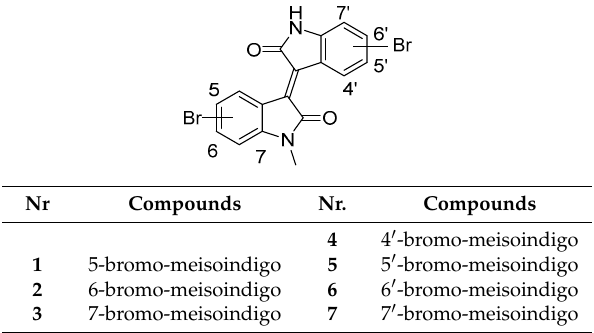
Table 1. Chemical structures of novel-bromomeisoindigos.